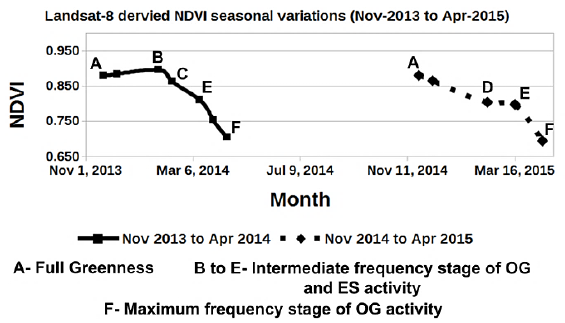
Figure 4: Landsat-8 derived NDVI trajectories along with phenological activities for Nov 2013 to Apr 2014 and Nov 2014 to Apr 2015